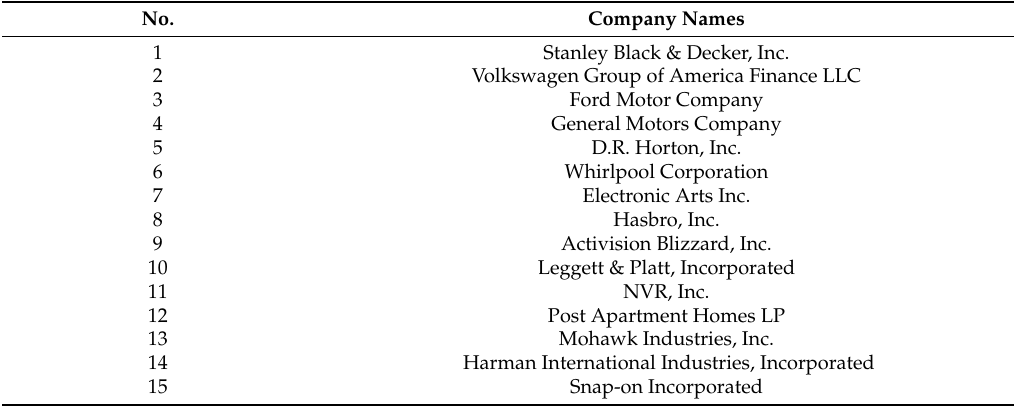
Table A1. List of companies. Source: Authors; FactSet data